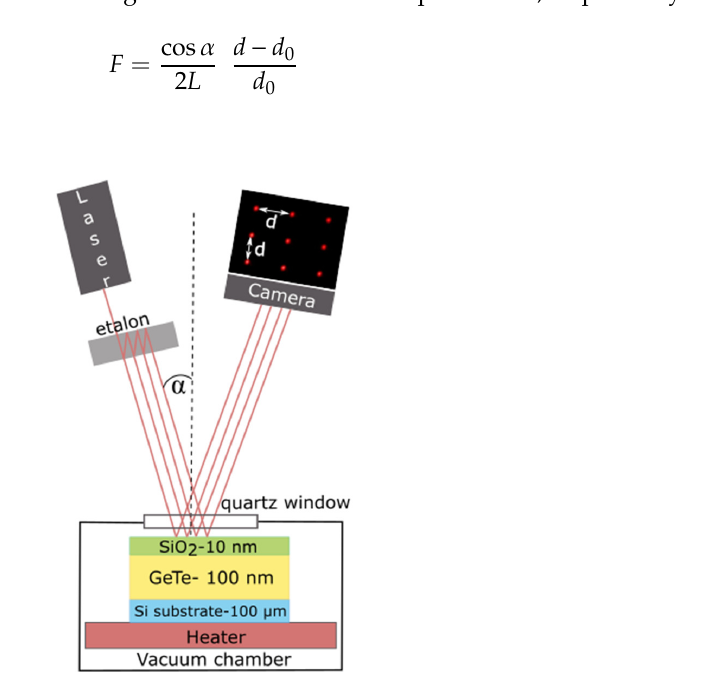
Figure 1. Schematic of wafer curvature measurement setup and sample layout of films used for isothermal measurements. The components in the figure are not to scale.